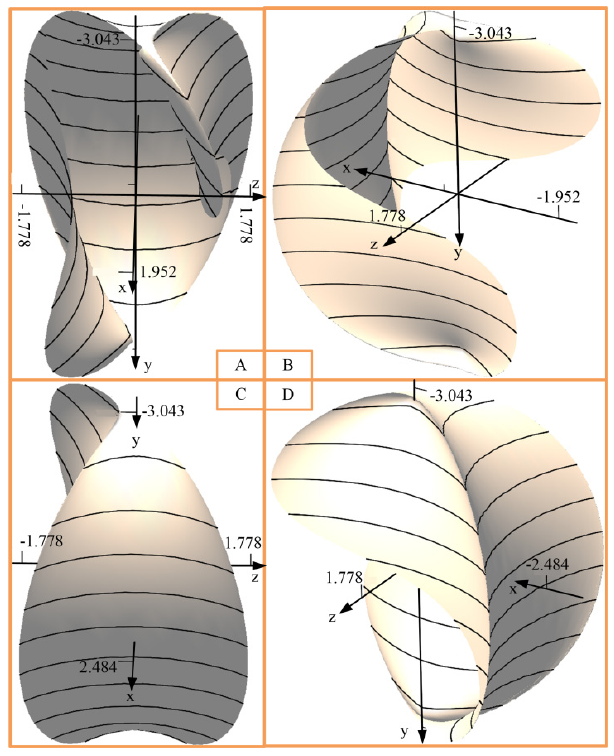
Figure 7. The top − and bottom − end striction point surfaces.